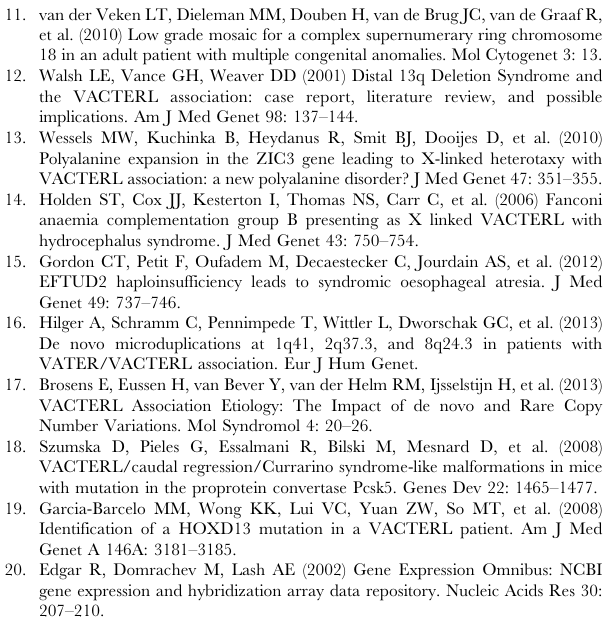
Table S2 Summary of genetic analyses performed in